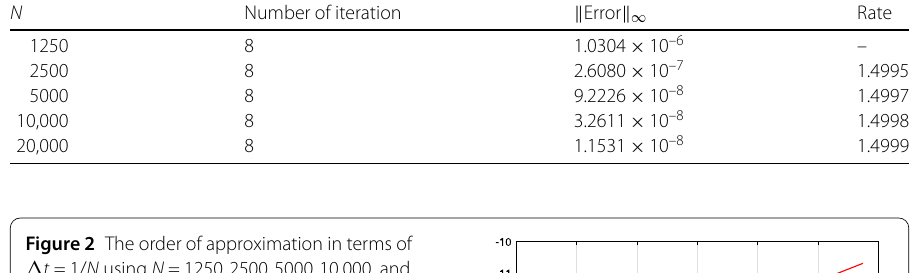
Figure 2 The order of approximation in terms of (cid:3) t = 1/ N using N = 1250,2500,5000,10,000,